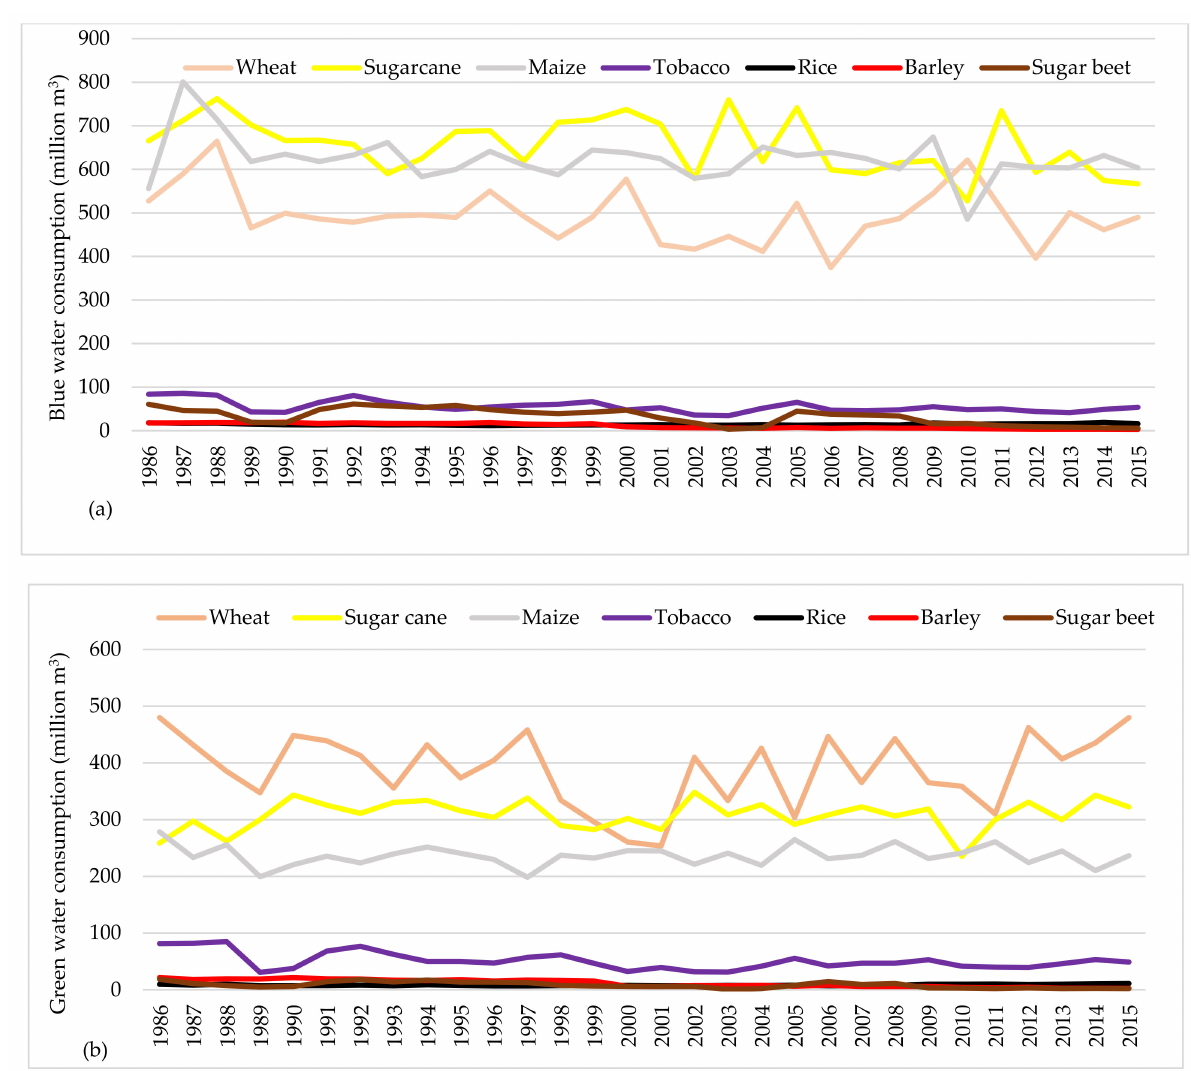
Figure 5. Variation in water consumption of major crops in Peshawar Basin (1986–2015), ( a ) blue water consumption (million m 3 ) and ( b ) green water consumption (million m 3